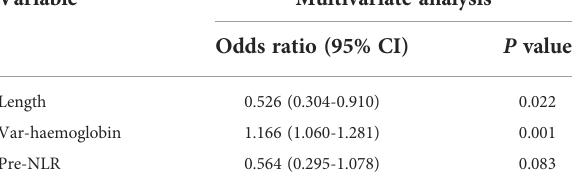
TABLE 4 Multivariate analysis of PD.